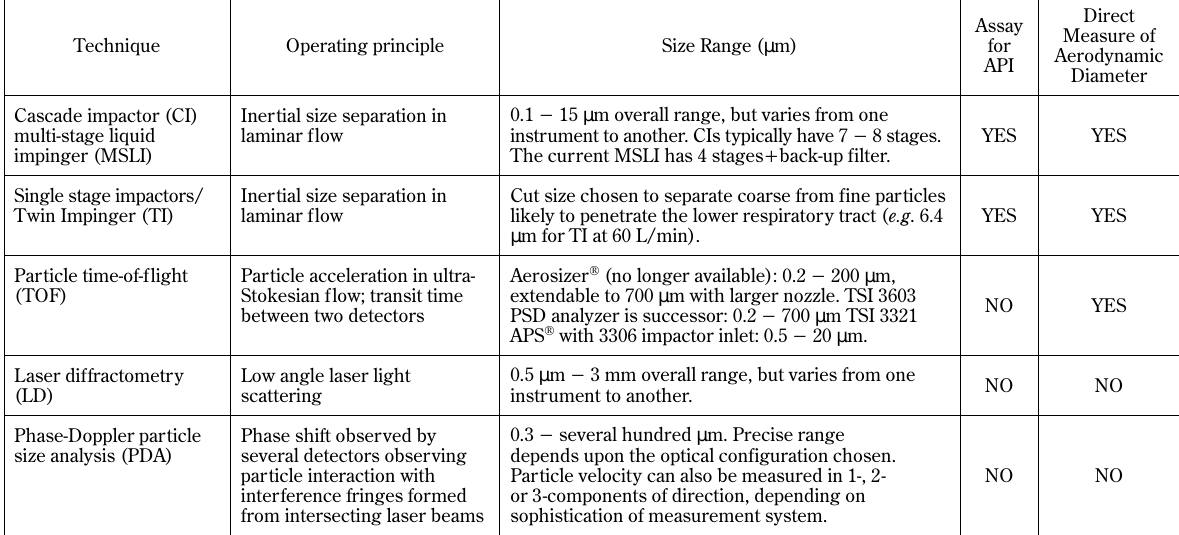
Table 3 Summary of particle sizing methods used to characterize medical aerosols from inhalers